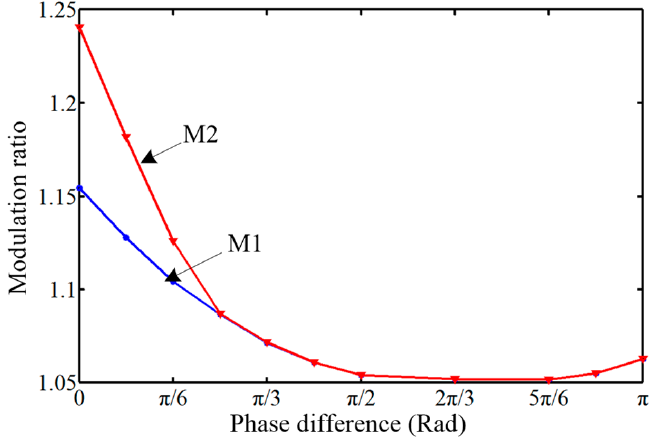
Figure 5. The modulation ratio comparison of combination method 1 (M1) and method 2 (M2).